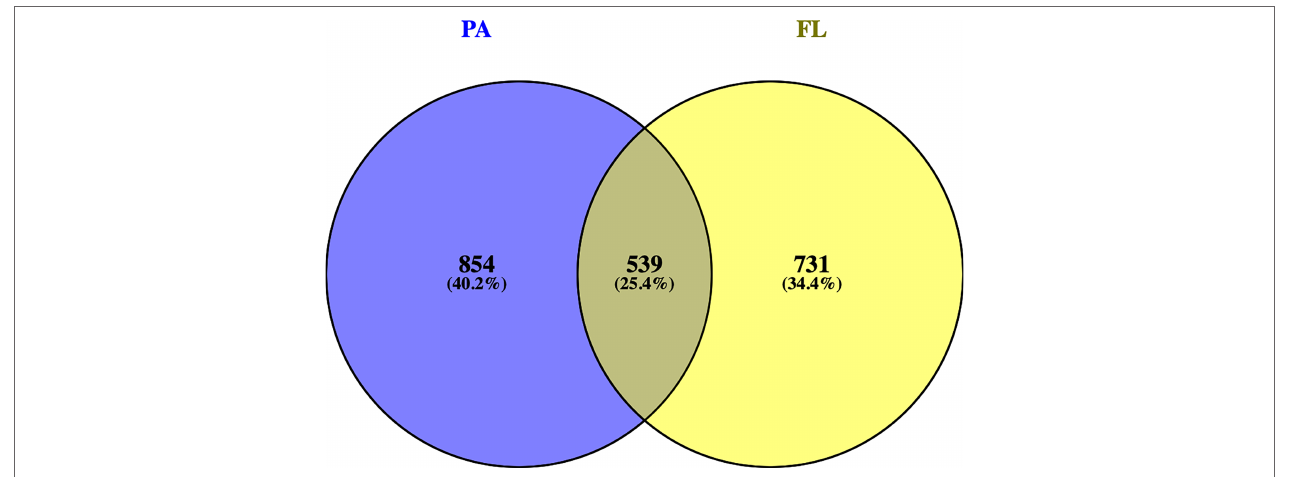
FIGURE 2 | Venn diagram showing the ASV distribution in each of the two fractions: FL (Free-Living, yellow) and PA (Particle-Attached, blue), and those shared by both